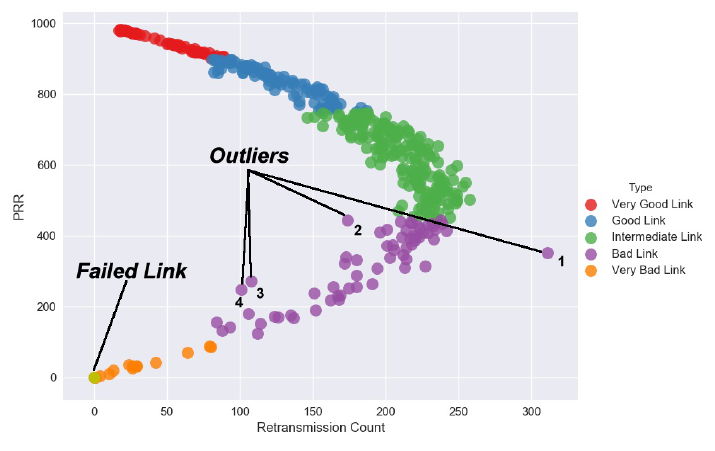
Figure 8. KLSVM Model: A visual intuition of the network